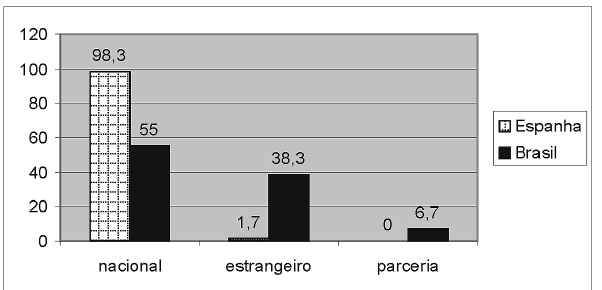
Figura 1. Centros ou universidades que publicaram sobre